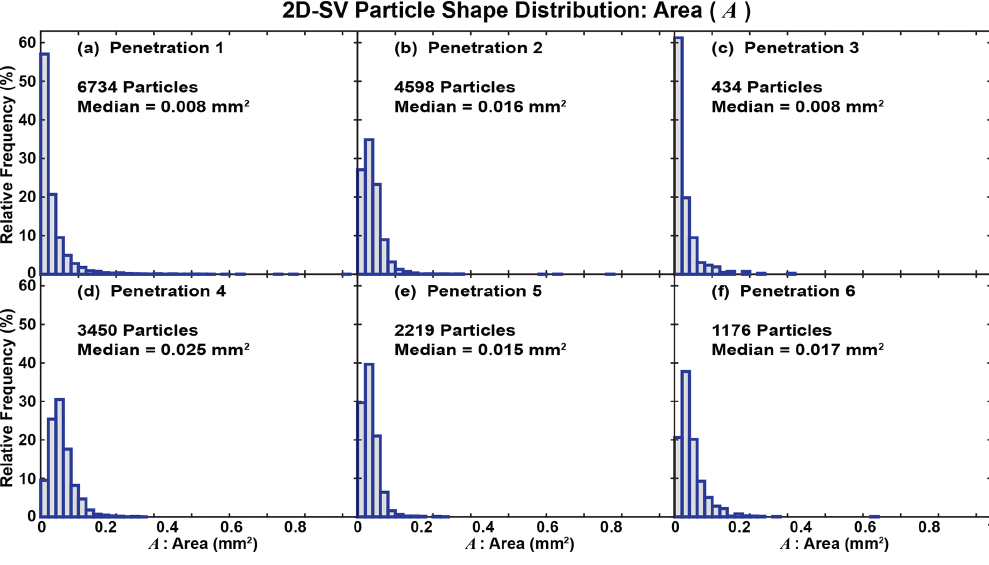
Figure 9. Same as Fig. 8 except for particle area ( A